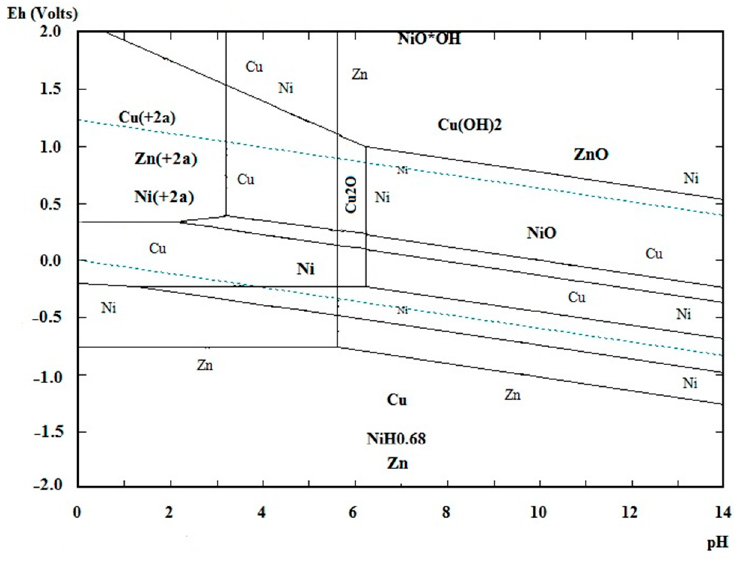
Figure 4. Pourbaix diagram of zinc, copper, and nickel metals at 25 ◦ C and 1 atmospheric